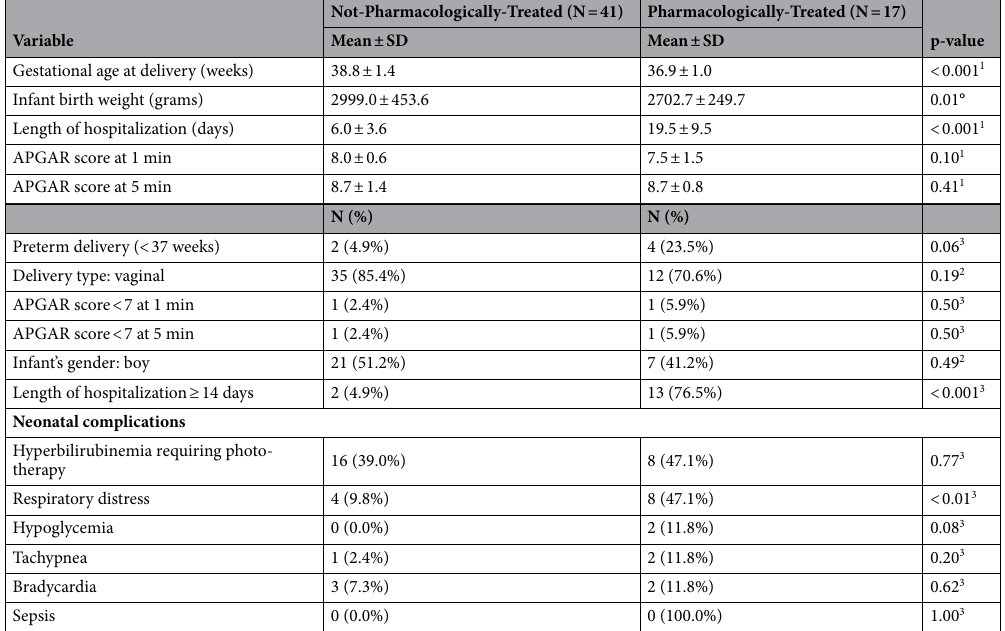
Table 3. Perinatal and infant characteristics. APGAR appearance, pulse, grimace, activity, and respiration score, NOWS neonatal opioid withdrawal syndrome, SD , standard deviation. °Based on pooled variances t-test. 1 Based on Mann–Whitney test. 2 Based on Chi-square test. 3 Based on Fisher’s exact test.